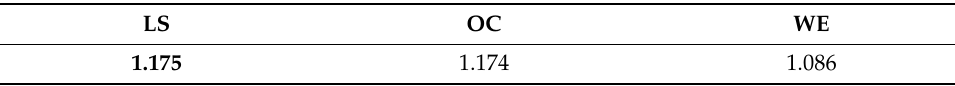
Table 2. Collinearity Statistics (VIF) Results.